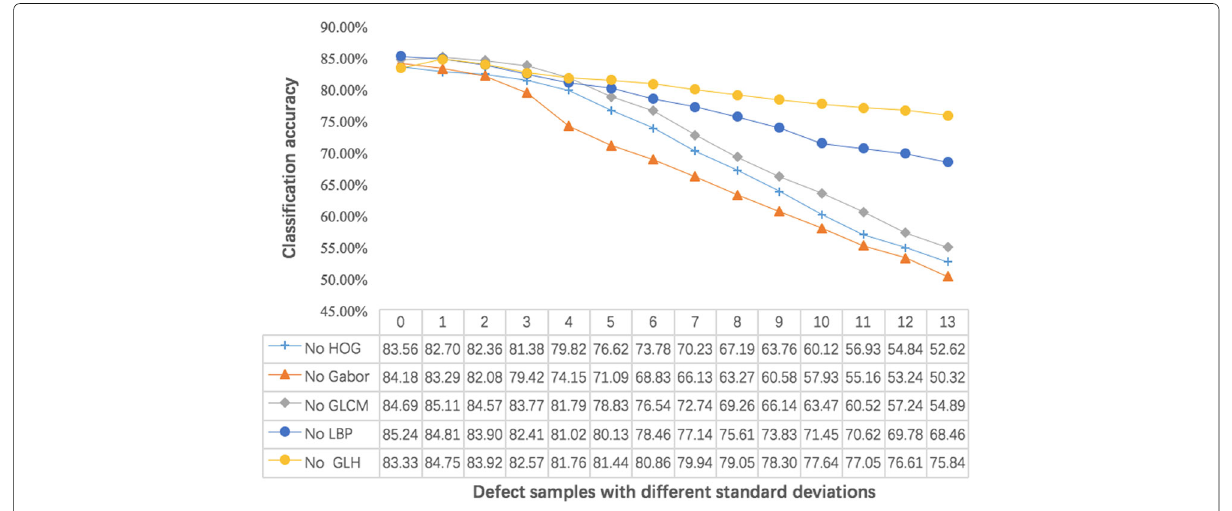
Fig. 11 The accuracy of BYEC classifiers adjusted by different features on the defect samples with standard deviations ( 0 − 13 )